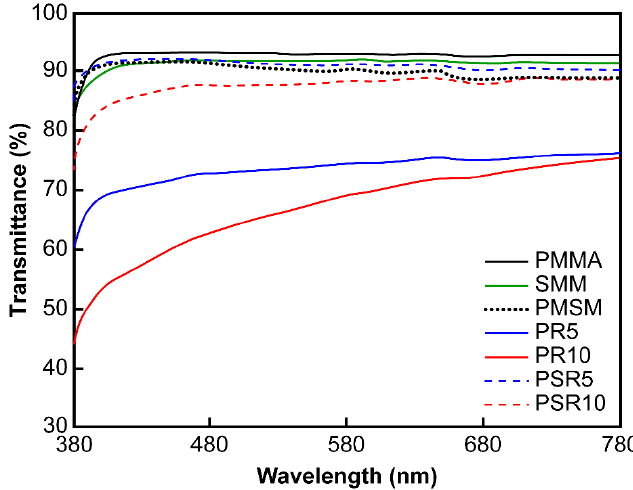
Figure 3. Transmittance spectra of the matrix resins, PMMA/PR blends, and the PMMA/SMM/PR